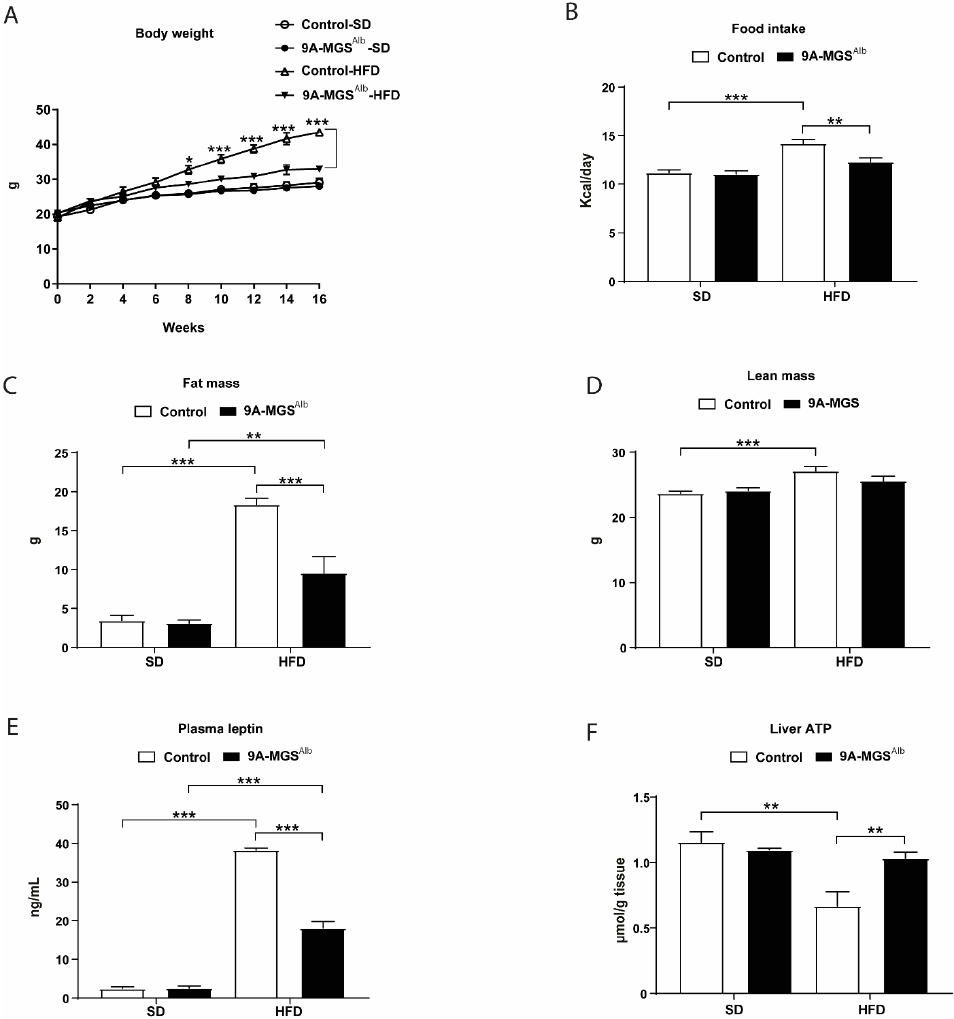
Figure 2. ( A ) Growth curve. Body weights were measured every other week. ( B ) Food intake. ( C ) Fat mass. ( D ) Lean mass. ( E ) Plasma leptin under fed condition. ( F ) Liver ATP under fed condition. Data are mean ± SEM. n= 6-10/group. * p <0.05, ** p <0.01, *** p <0.001.